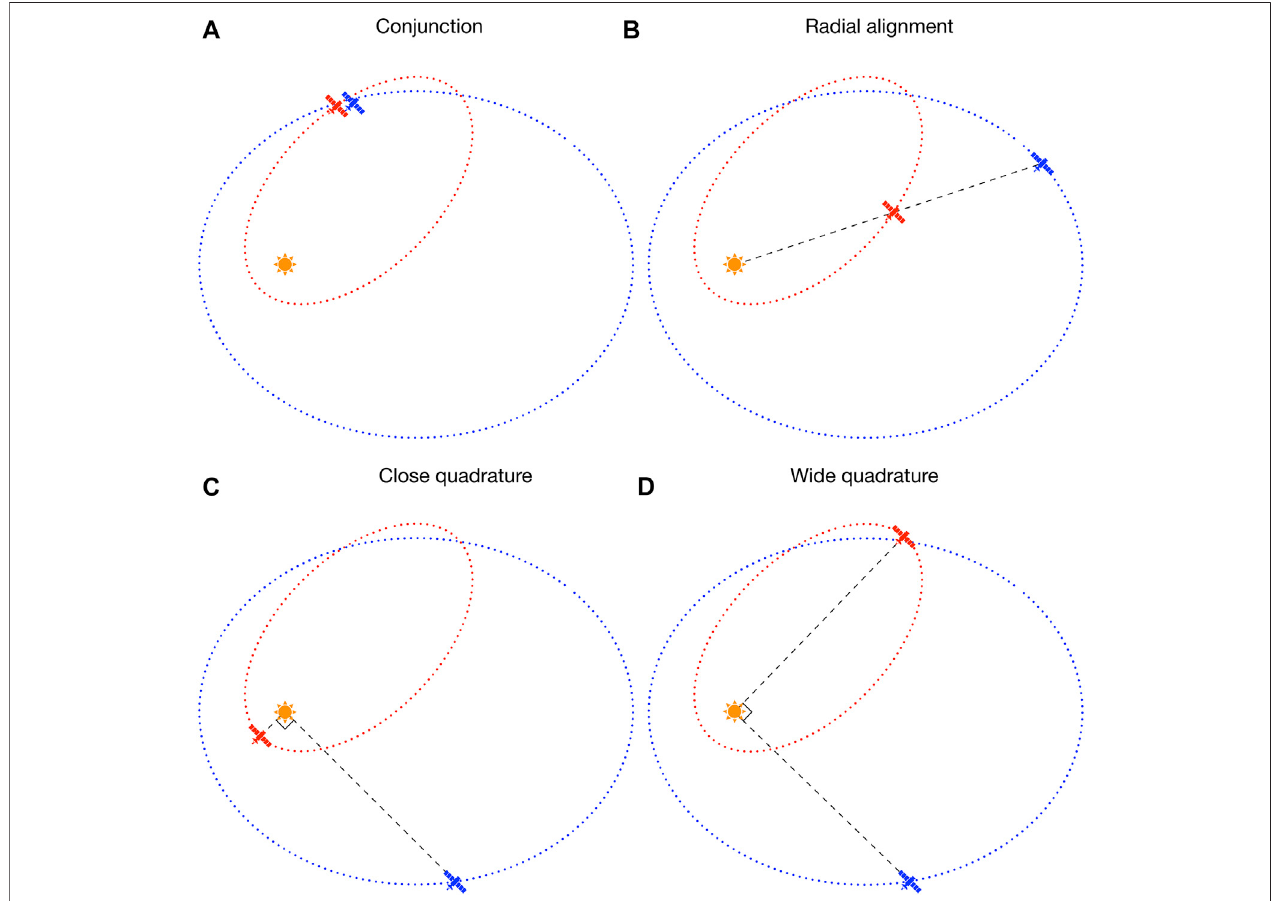
FIGURE 1 | Sketches of particular geometrical con fi gurations between SQUARE 2 s/c #1 (red) and s/c #2 (blue) while orbiting around the Sun (yellow star) along their relative trajectories (color-coded dotted lines): spacecraft conjunction (A) , radial alignment (B) , close (C) and wide (D) quadratures. The s/c — Sun lines, during alignments and quadratures, are marked as dashed